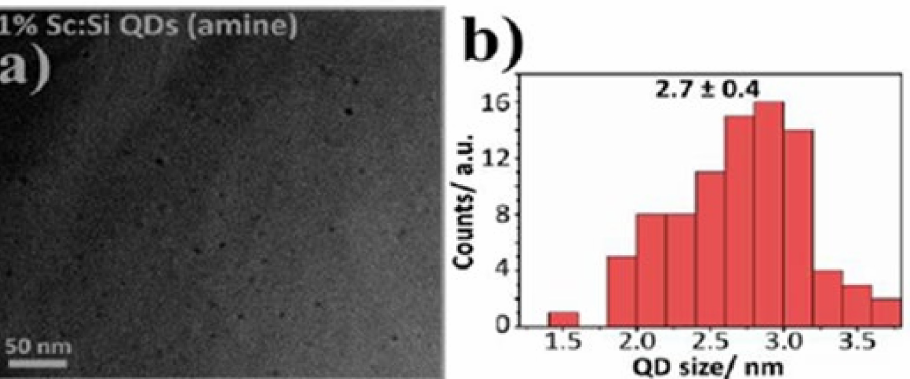
Figure 2. TEM image and size distribution of Sc-SiQDs. The amine-capped scandium-doped SiQDs indicate their optimal size for inducing fluorescence. Figures ( a ) and ( b ) show the TEM image (morphology) and size distribution of the SiQDs,